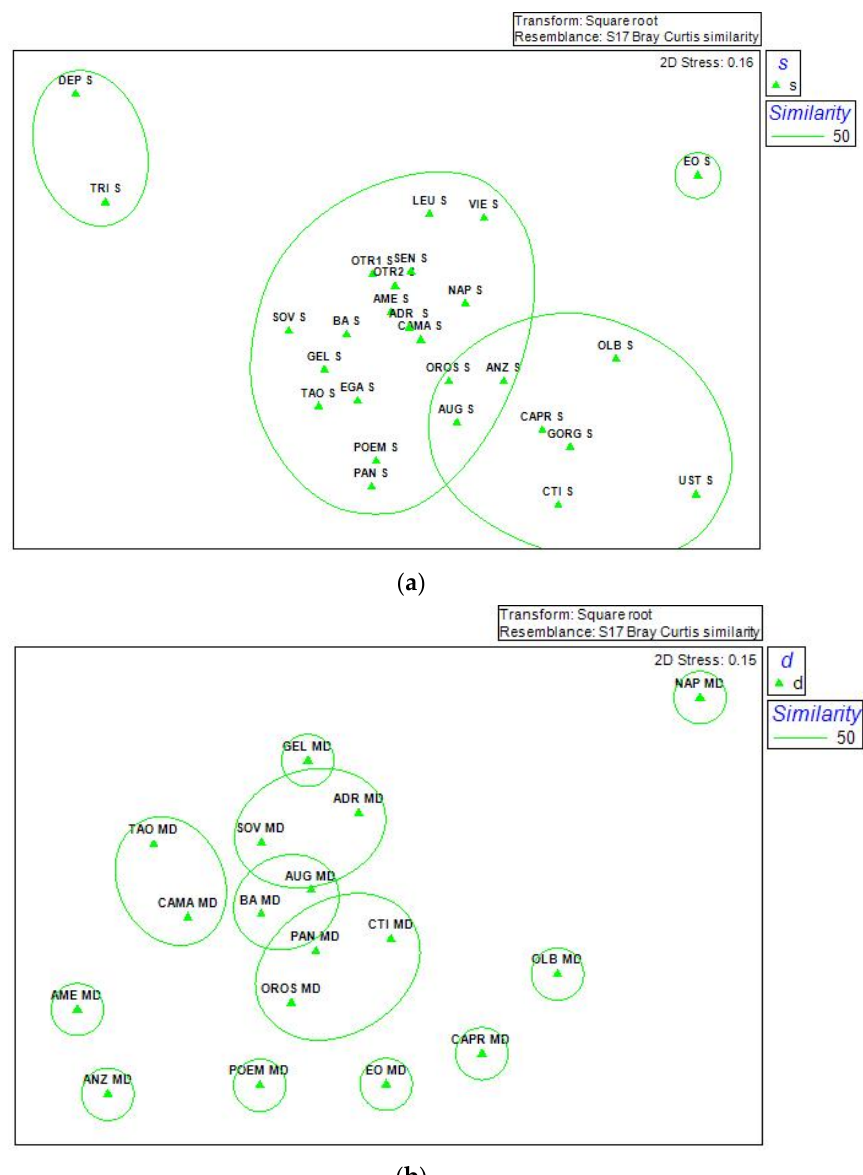
Figure 9. Cruise 2017. Representation of non-parametric Multidimensional Scaling (nMDS) of ( a ) epipelagic sample (s), 27 stations (2–4 m below the sea level), and ( b ) mesopelagic samples (d) (200–500 m below the sea level), from 17 stations.